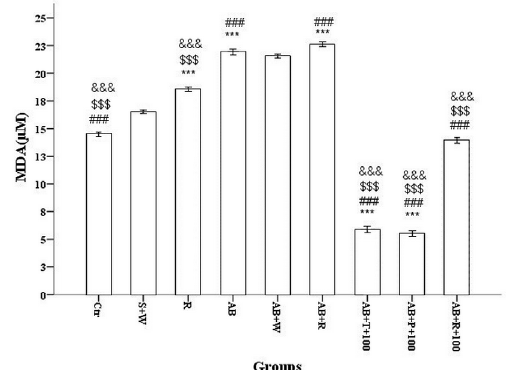
FIGURE 2 - Overall serum level of MDA in different groups. Comparison of control group (Ctr) with other groups (*** p<0.001); comparison of restraint (R) group with other groups (### p<0.001); comparison of AD group (AB) with